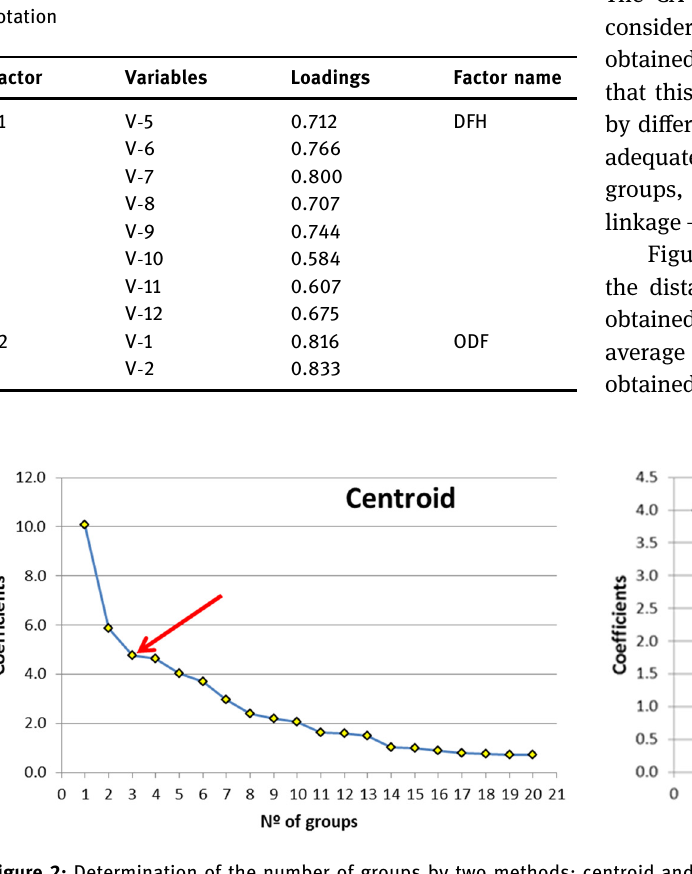
Figure 2: Determination of the number of groups by two methods: centroid and average linkage within